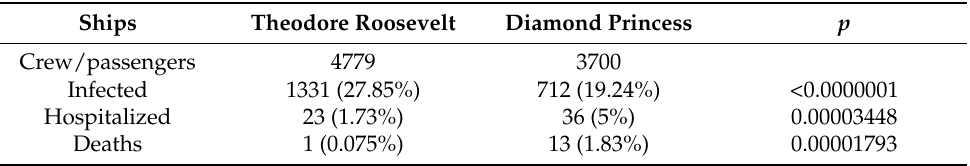
Table 6. COVID-19 infections in the aircraft carrier Theodore Roosevelt and in the cruise ship Diamond Princess. Ships Theodore Roosevelt Diamond Princess p Crew/passengers 4779 3700 Infected 1331 (27.85%) 712 (19.24%) <0.0000001 Hospitalized